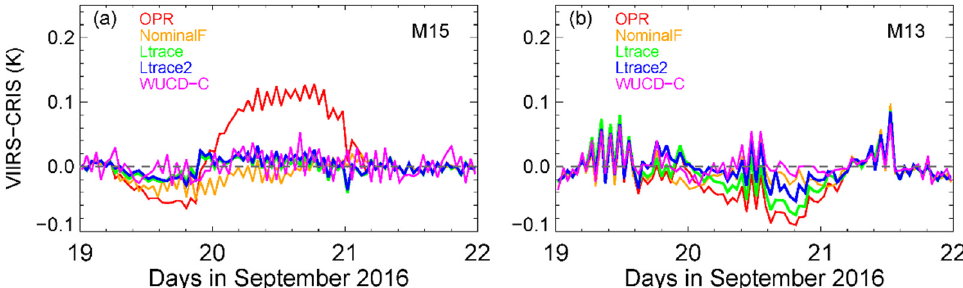
Figure 2. S-NPP VIIRS TEB WUCD biases for M15 ( a ) and M13 ( b ): no correction (NOAA operational or OPR, red color), after the Nominal-F correction (yellow), the Ltrace correction (green), the Ltrace-2 correction (blue), and the WUCD-C correction (magenta). VIIRS operational and reprocessed sensor data records (SDRs) during the 19–21 September 2006 WUCD events were used.